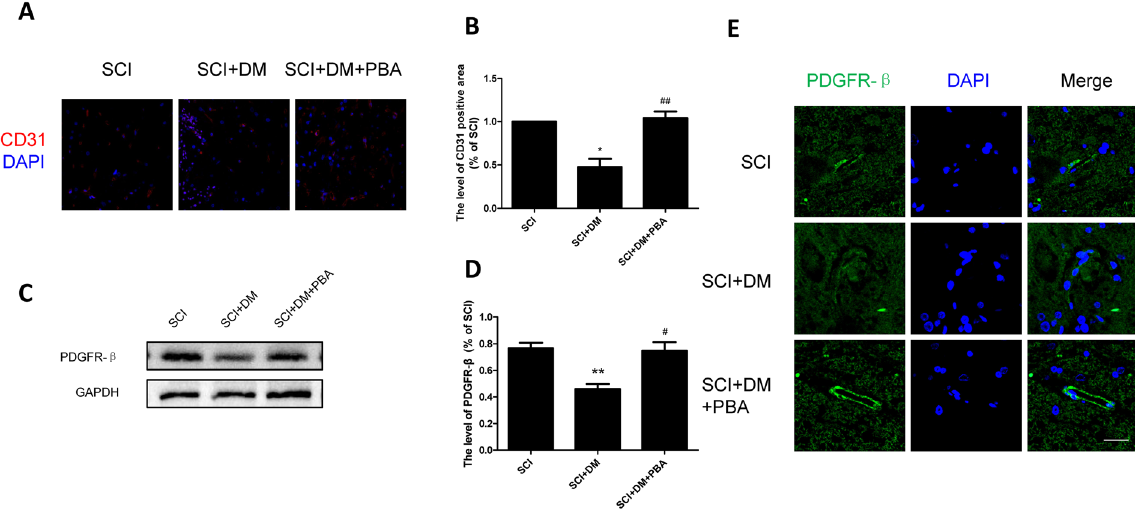
Figure 7. Inhibiting ER stress preventes microvessels loss and increases pericyte coverage in diabetic rats after SCI. ( A , B ) Immunofluorescence staining of CD31 and quantification of the level of CD31 positive areas in each group, n = 4. Scale bar = 50 μ m. ( C , D ) Western blot and quantification of PDGFR- β in each group, n = 6. ( E ) Immunofluorescence staining of PDGFR- β in each group, n = 4. Scale bar = 10 μ m. * p < 0.05, ** p < 0.01 vs SCI group, # p < 0.05, ## p < 0.01 vs SCI + DM